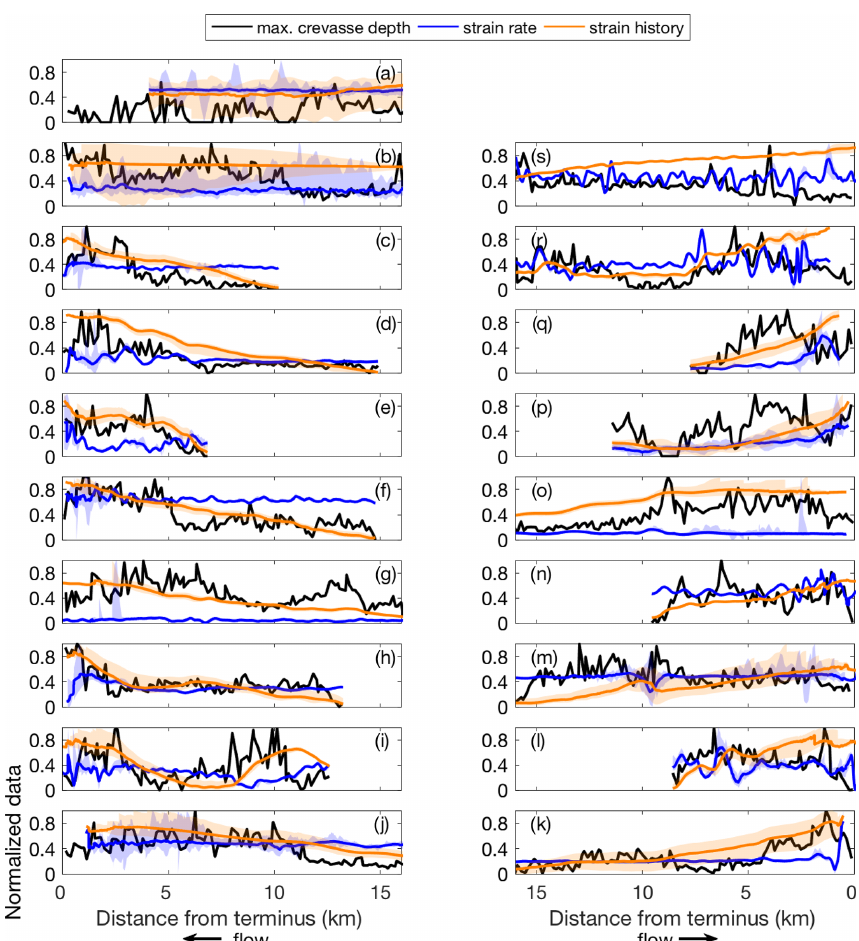
Figure 3. Normalized profiles of maximum crevasse depth, local strain rate, and strain history. In each panel, the maximum crevasse depth in 150m wide bins is in black, the local strain rate is in blue, and the strain history is in orange. The median strain rate and strain history are shown as lines with shading indicating their temporal ranges. As in Fig. 2, the panels are geographically